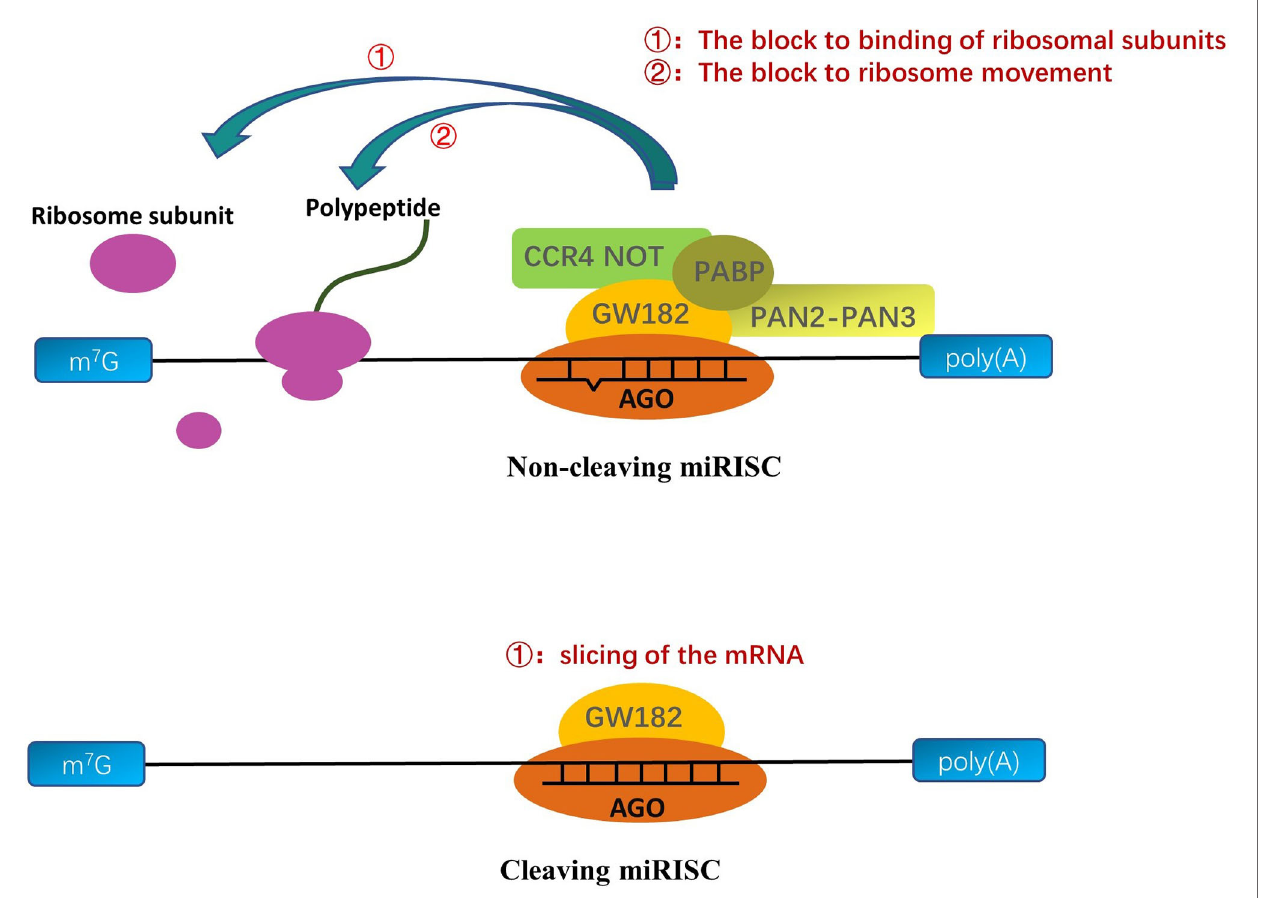
FIGURE 2 | A molecular understanding of miRNA-mediated gene silencing. When the miRNA sequences are partly complementary to the targeted RNA sequences, the AGO protein binds to GW182; then, the complex recruits PABP, CCR4 NOT, and PAN2-PAN3 to interferences ’ ribosome movement on the mRNA/viral RNA (vRNA) or prevents the binding of ribosomal large and small subunits to inhibit translation. When the miRNA sequences are perfect complementary to the targeted RNA sequences, cleaving-miRISC composed of miRNA and AGO protein cuts and degrades the targeted transfer RNA to inhibit